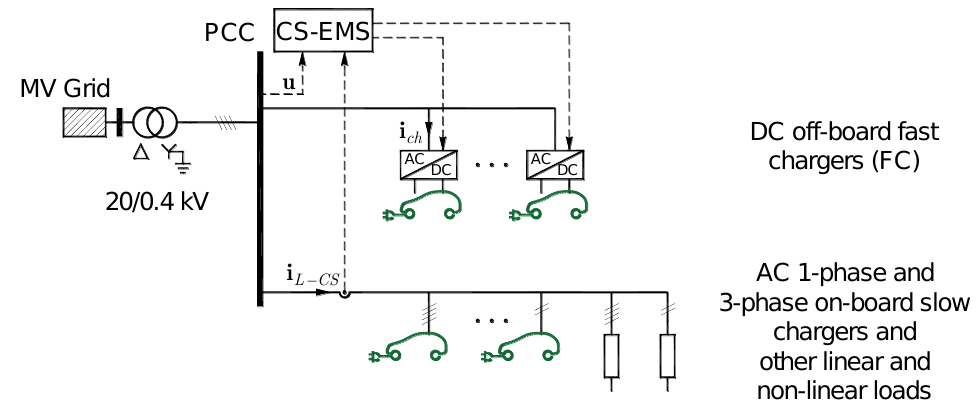
Figure 1. Charging station facility Figure 1 . Charging station facility architecture.